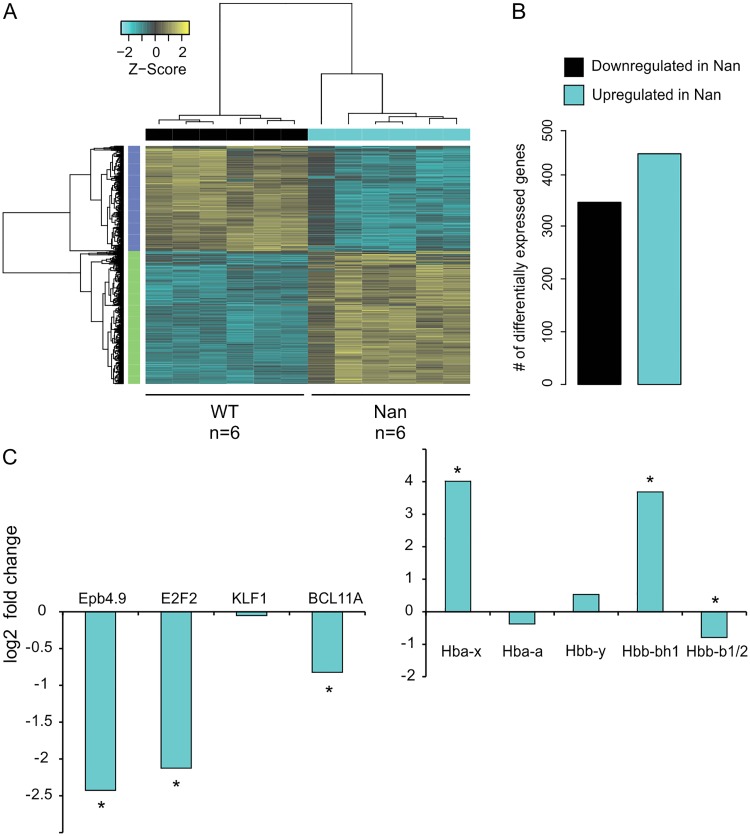
RNA-seq analysis of wildtype and Nan fetal liver cells.(A) Hierarchical clustered heat map with scaled Z-score color key of normalized counts of 782 differentially expressed genes in 6 wildtype (WT) and 6 Nan (Nan) E12.5 fetal liver samples. Samples with the same genotype are indicated by black (WT) and cyan (Nan) horizontal bars; gene clusters are indicated by green (upregulated in Nan) and purple (downregulated in Nan) vertical bars. False discovery rate [FDR] <0.01, fold-change equal or greater than 1.5. (B) Schematic representation of the number of downregulated and upregulated genes in the Nan E12.5 fetal livers. (C) Log2 values of fold-change for selected genes. * indicates FDR <0.01.